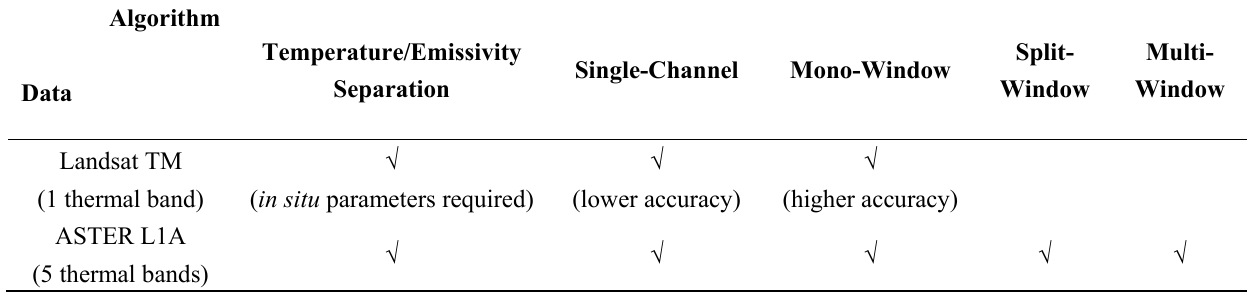
Table 2. LST retrieval